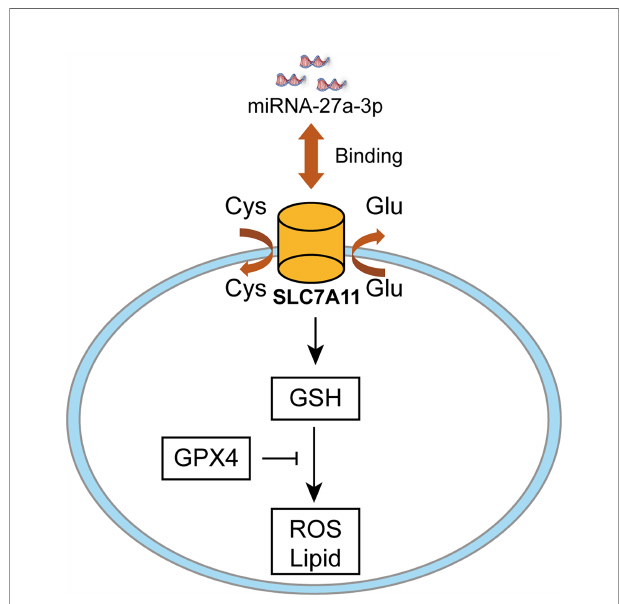
FIGURE 6 | Schematic of the working details of miR-27a-3p/SLC7A11 in NSCLC.